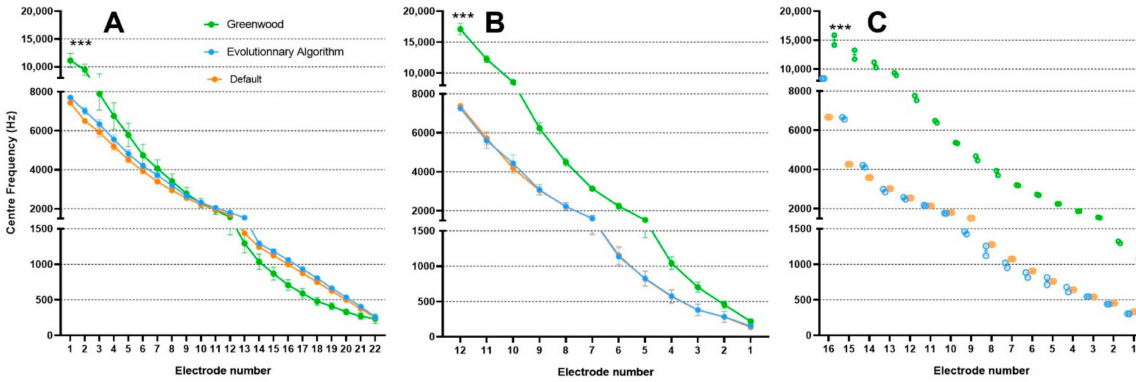
Figure 5. Center frequencies of electrodes according to the Greenwood map calculated on the post- operative CT scan, the default setting, and the evolutionary algorithm (EA) in Cochlear ® ( A , n = 7), MED-EL ® ( B , n = 6) and Advanced bionics ® ( C , n = 2) cochlear implants. Values are expressed as mean ± standard error of mean. For Advanced Bionic (panel C ), individual values are depicted. Center frequencies according to the Greenwood map differed from default and EA settings. *** p < 0.001 for the effects of settings, electrode position, and interaction in all 3 brands, two-way ANOVA.